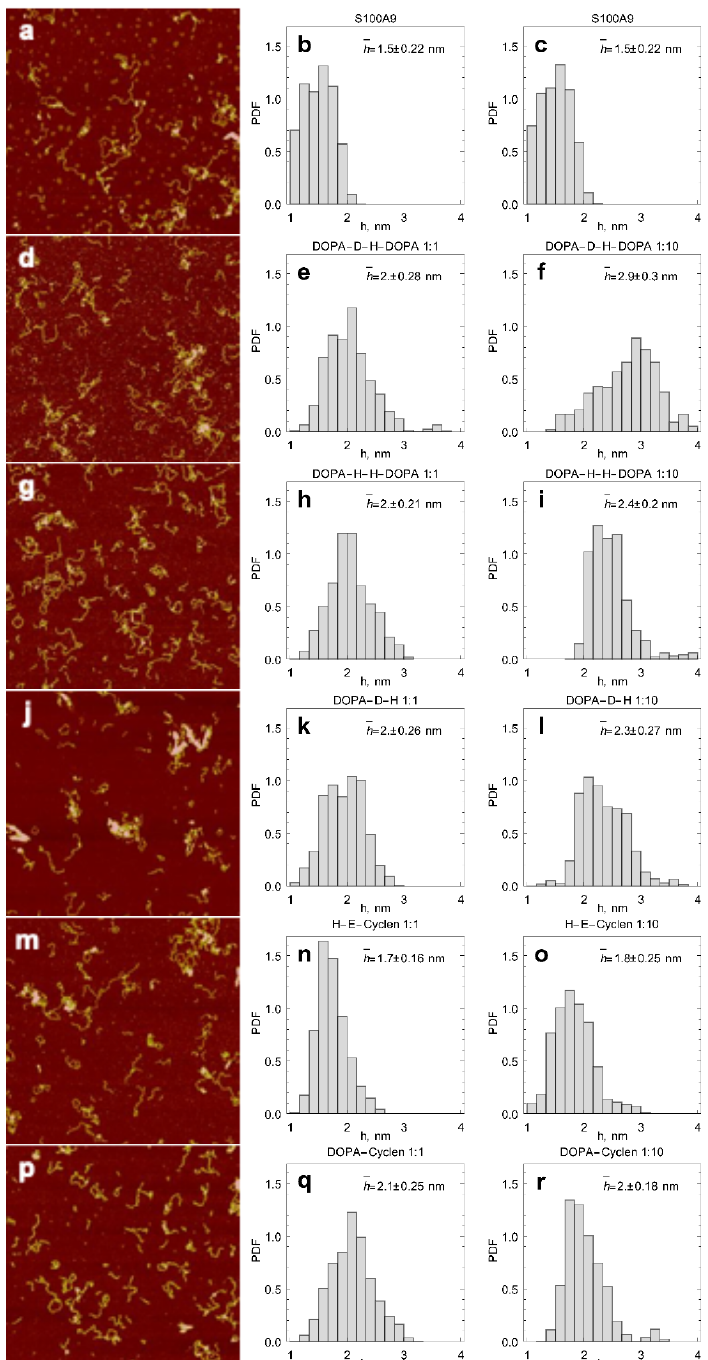
Figure 3. AFM imaging of S100A9 fibrils in the absence and presence of DOPA and cyclen-based compounds and the analysis of fibril height distributions. ( a ) Representative AFM image of S100A9 fibrils incubated alone. ( b , c ) Distribution of fibril heights measured in AFM cross-sections. The same distribution is shown in both columns to facilitate the comparison with the following height distributions carried out in the presence of compounds. ( d , g , j , m , p ) Representative AFM images of S100A9 fibrils in the presence of DOPA and cyclen-based compounds at a 1:1 molar ratio of S100A9 to compound. ( e , h , k , n , q ) Distributions of fibril heights measured in AFM cross-sections at the S100A9 to compound molar ratio of 1:1 and ( f , i , l , o , r ) at molar ratio of 1:10. Image sizes are 2.5 × 2.5 µ m. The compounds and molar ratios are indicated above the figures. Samples were incubated for 50 h in PBS, pH 7.4, and 42 ◦